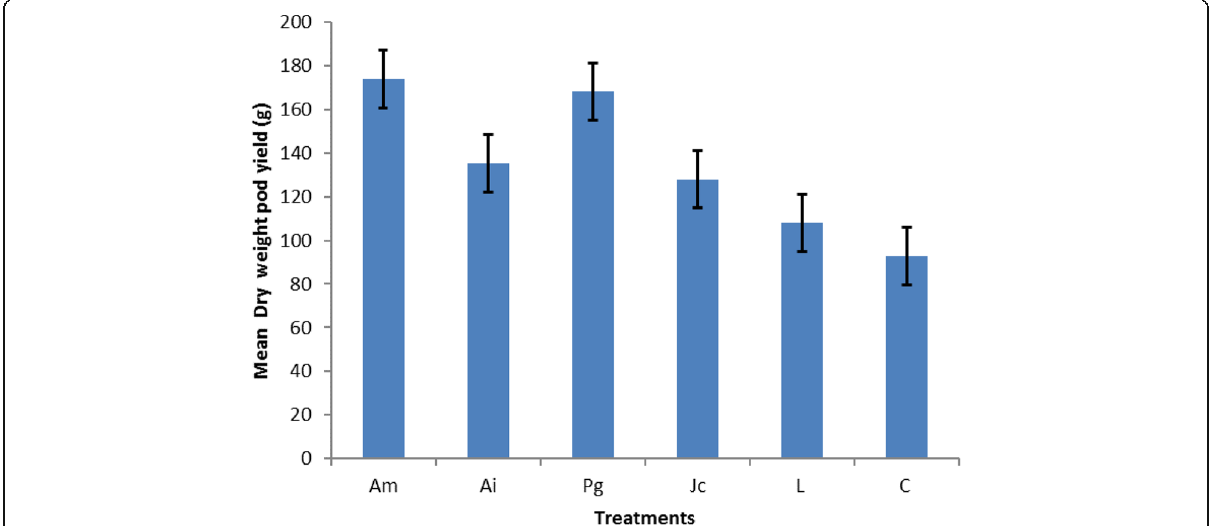
Fig. 4 Effect of treatments on the dry weights (gram) of cowpea pod. Mean values are the dry weight of cowpea pod harvested from different plots treated with different botanicals. Am, plot treated with Annona muricata ; Ai, plot treated with Azadirachta indica ; Pg, plot treated with Piper guineense ; Jc, plot treated with Jatropha curcas ; L, lambdacyhalothrin; C, control (no